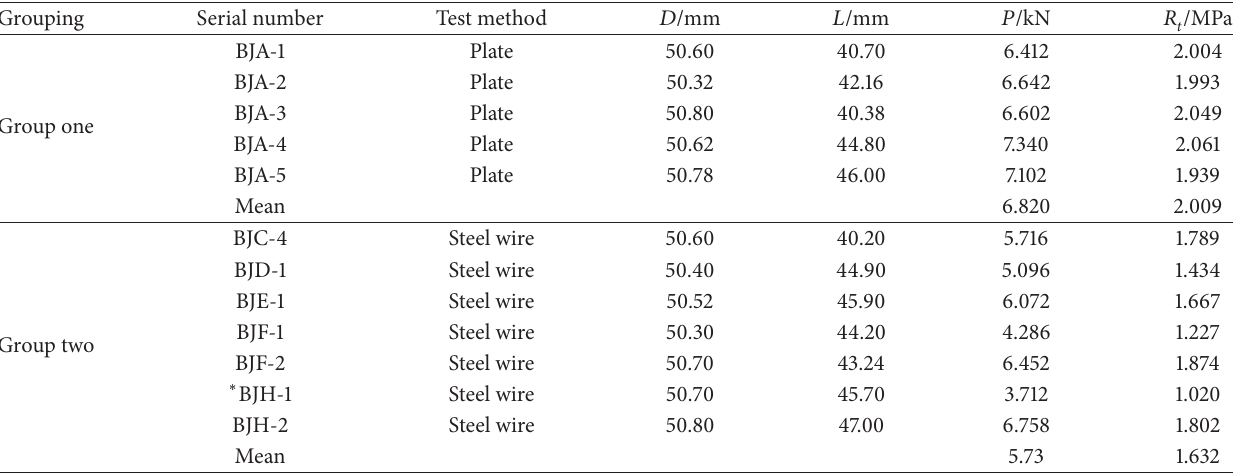
Table 1: Brazilian split test results of rock salt.